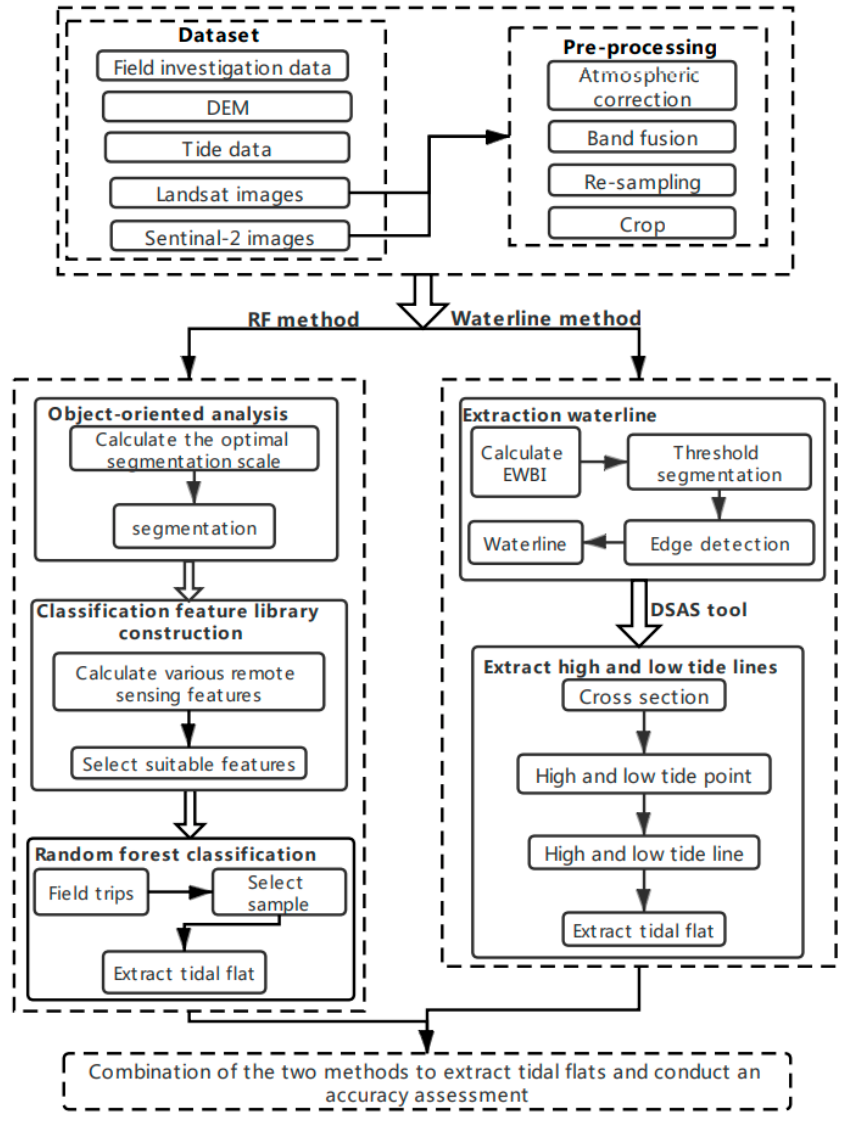
Figure 3. Workflow used in this study for tidal flat extraction.